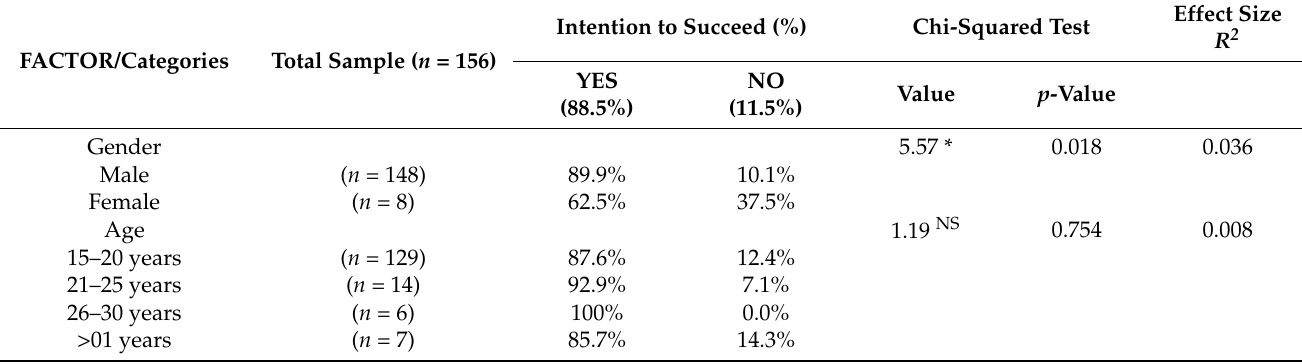
Table 1. Comparative inferential analysis. Intention to continue the FFs depending on the gender and age of the participant ( n = 156).